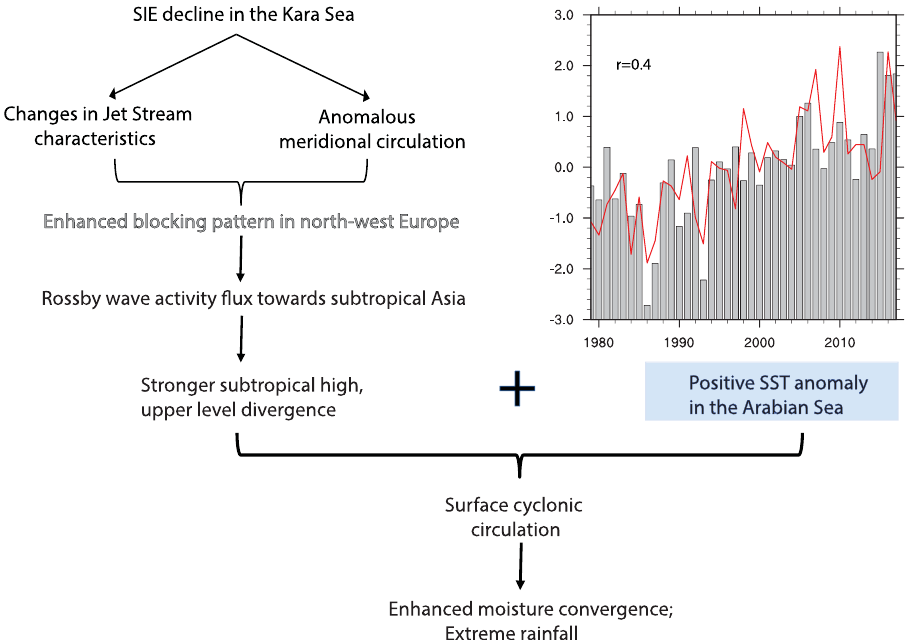
Fig. 5 Schematic of the suggested mechanism between SIE in KS and ISMR extremes during September. The time series at the top right corner shows the variability in normalized 200 hPa geopotential height anomaly in August – September over the northwest Europe region (indicated by grey bars, 55 o N:70 o N, 10 o E:50 o E) and the subtropical East Asian region (indicated by red line, 30 o N:50 o N, 90 o E:130 o E). The correlation between the detrended timeseries is 0.4 as indicated in left